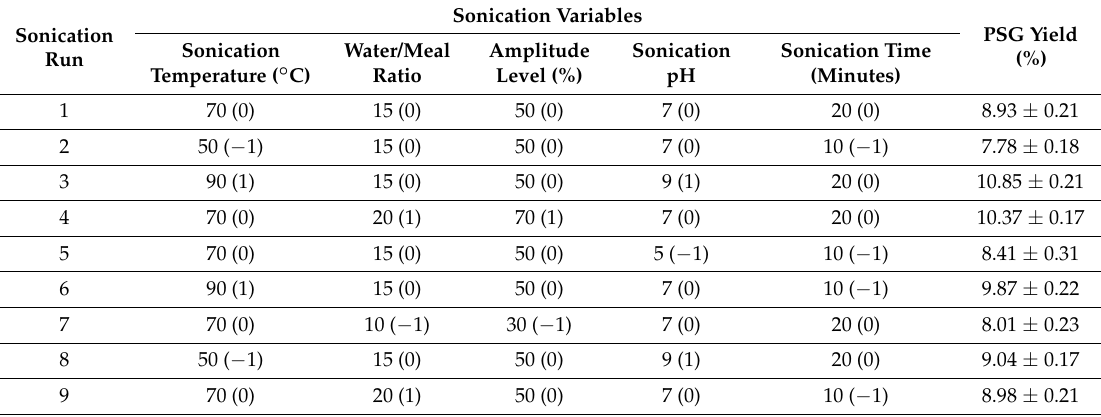
Table 3. Percentage of flaxseed PSG yield as carried out by the Box–Behnken design. Sonication